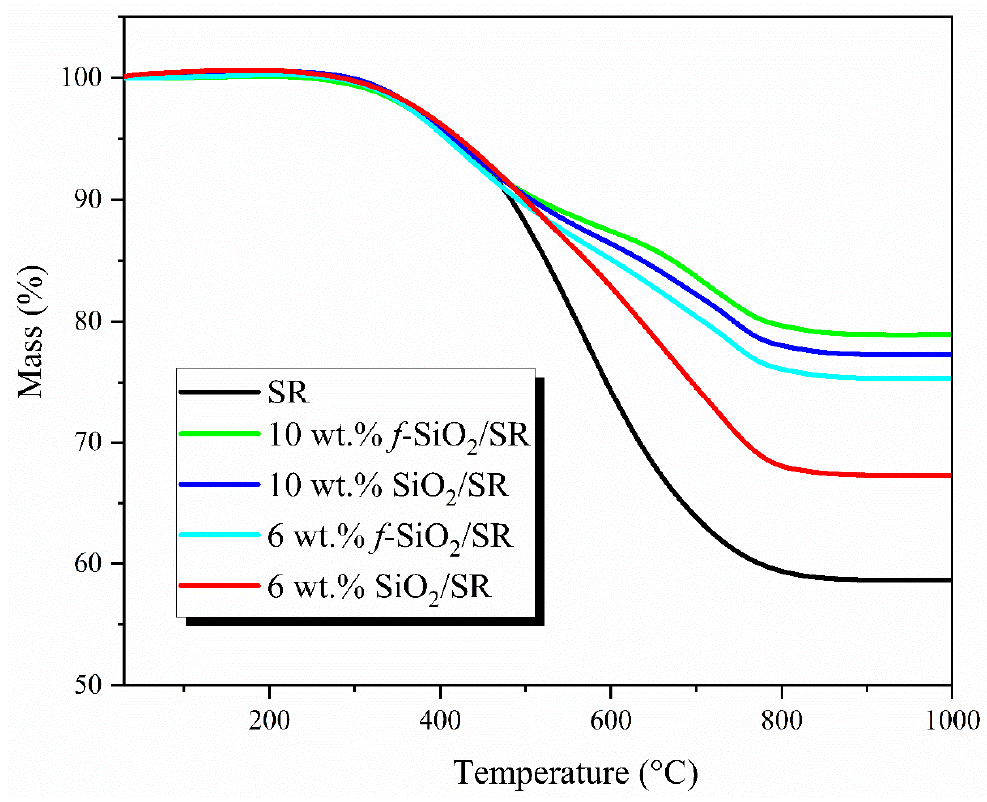
Figure 7. Thermal stability of the SR composites filled with f -SiO 2 and SiO 2 at the filler content of 6 wt.% and 10 wt.%. Table 3. Thermal stability of f -SiO 2 /SR composites.